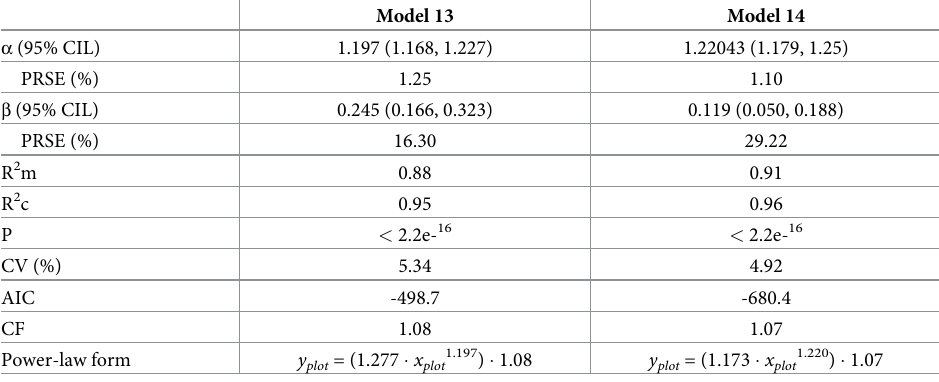
Table 5. Evaluation of models 13 and 14 to estimate tree aboveground plot biomass density of cerrado sensu stricto .